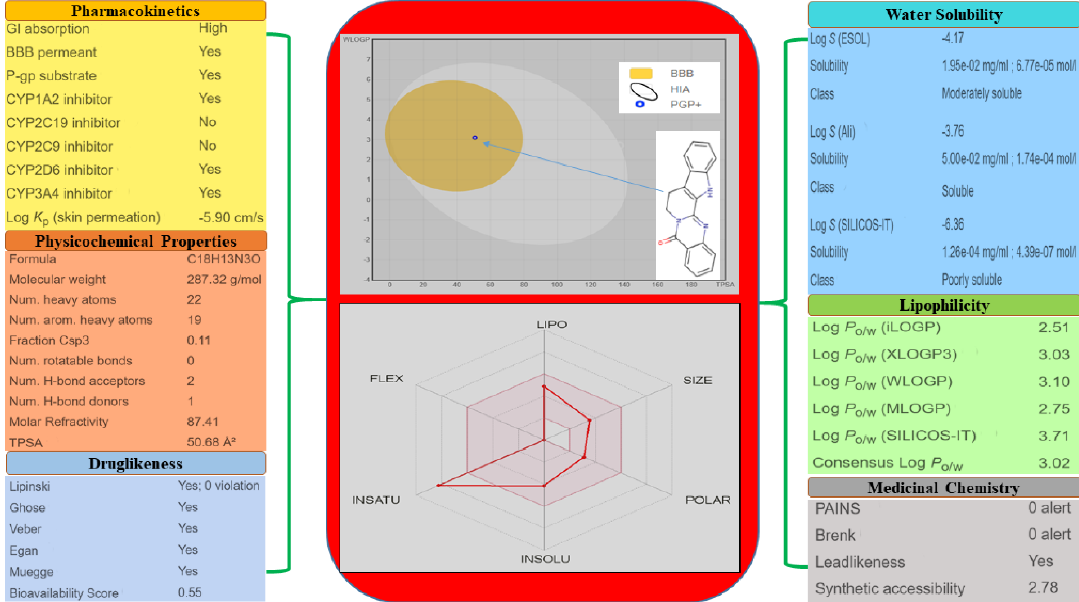
Figure 5. Physicochemical and drug-likeness properties of rutaecarpine.